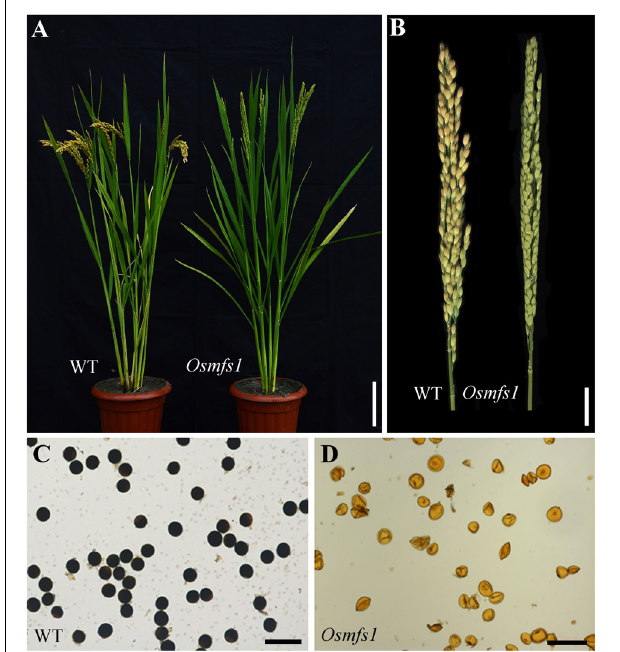
FIGURE 1 | Phenotype analysis between the WT and the Osmfs1 mutant. (A) Comparison between a WT plant (left) and an Osmfs1 mutant (right) plant at the heading stage. Bars = 10 cm. (B) Comparison between a WT panicle (left) and an Osmfs1 mutant panicle (right) at the harvest stage. Bars = 2 cm. (C) Viable pollen grains in a WT plant. (D) Inviable pollen grain in an Osmfs1 mutant plant. Bars = 100 µ m in panels (C,D)